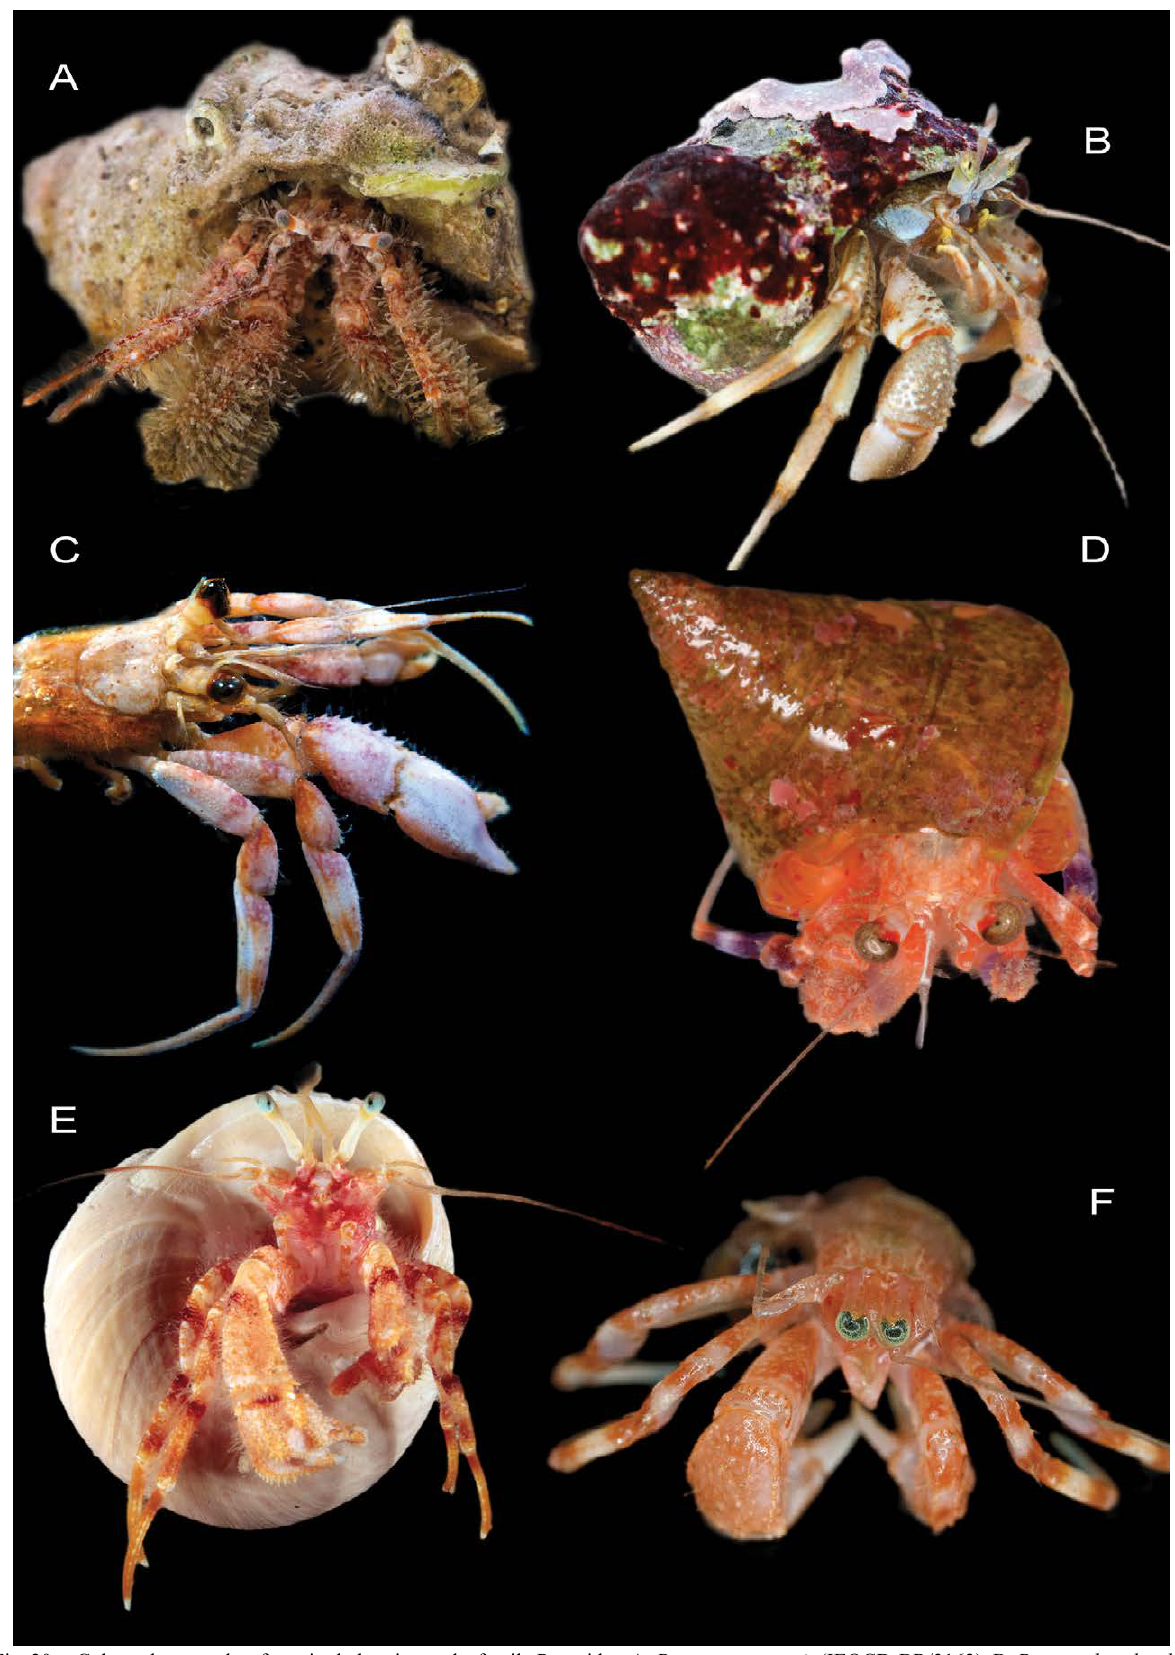
Fig. 20. – Colour photographs of species belonging to the family Paguridae. A, Pagurus cuanensis (IEOCD-BR/3163); B, Pagurus bernhardus (IEOCD-BR/3185); C, Pagurus mbizi (IEOCD-BR/3180); D, Pagurus prideaux (IEOCD-BR/3166); E, Pagurus forbesii (© Jacinto Pérez); F, Pagurus pubescens